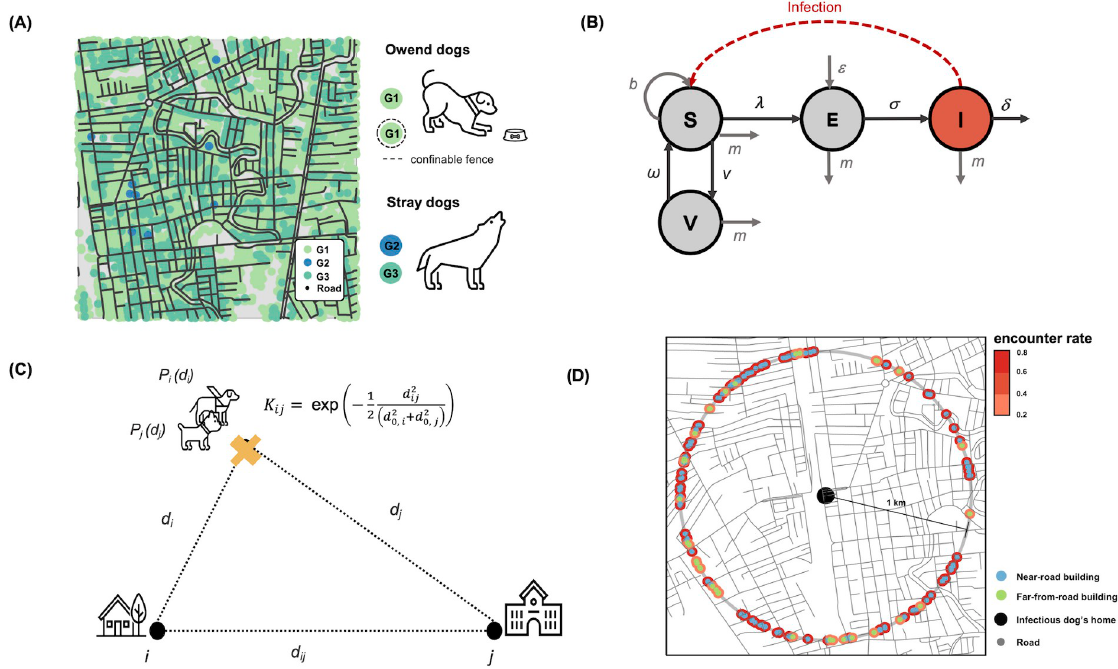
Fig 1. Structure of the canine rabies transmission model. (A) Example of the geographical distribution of buildings and roads in an area of 2x2 km 2 . Owned dogs reside only in G1 buildings, while unowned free-roaming dogs may occupy either G2 or G3 buildings. (B) Schematic of the transmission model. Based on the infection status, the model classifies each dog into susceptible ( S ), exposed ( E ), infectious ( I ), and vaccinated ( V ) classes. The dashed arrow represents transmission events, and the solid arrows indicate transitions between compartments. (C) Illustration of the probability of finding a dog at distance d from their home location, P ( d ), and the unnormalized encountering rate between dog i and dog j , K ij . (D) An illustrative example of the unnormalized encountering rate between a rabid dog residing at the centered black point and susceptible dogs living one kilometer apart. The blue and green dots on the map represent the home locations of susceptible dogs that are located near roads and far from roads, respectively. The unnormalized encountering rates are indicated by the colors of the dot